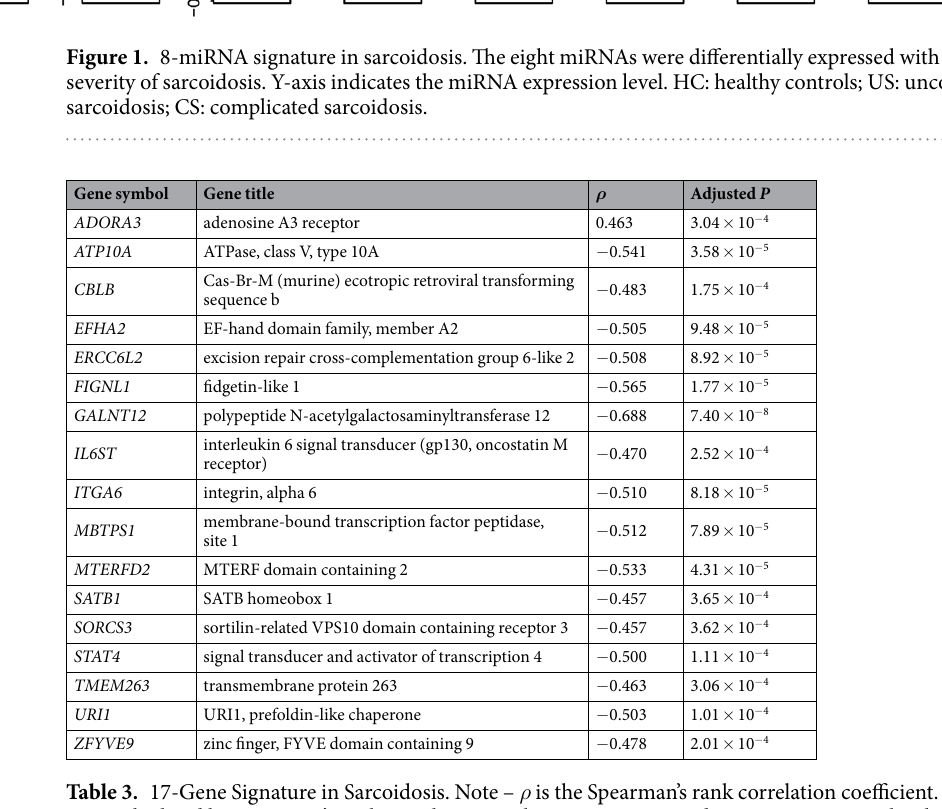
To understand the discriminative power of the 17-gene signature in distinguishing sarcoidosis from other lung diseases, we collected two more blood transcriptomic datasets (GEO accession: GSE42826 and GSE4257), the first consisted of 52 healthy controls, 25 sarcoidosis patients, 11 tuberculosis (TB) patients, six pneumonia patients, and eight lung cancer patients. TB, pneumonia patients, lung cancer were considered as non-sarcoidosis lung disorders. The second dataset comprised of 123 healthy controls, 87 and 47 cases with COPD and sarcoidosis respectively. Principal component analysis on the expression of the 17-gene signature in this dataset indicates that the first principal component significantly differentiates the sarcoidosis patients from the non-sarcoidosis lung disorders in both datasets (t-test: P = 1.9 × 10 − 2 and 2.09 × 10 − 5 ) (Supplementary Figs S5 and S6), which suggests that the 17-gene signature is able to distinguish between sarcoidosis and non-sarcoidosis lung disorders. To compare the effect of systemic corticosteroids on our 17-gene signature, we also surveyed a gene expression data set (GSE67255) on 18 healthy subjects before and 24 hours after the administration of glucocorticoids 19 . The